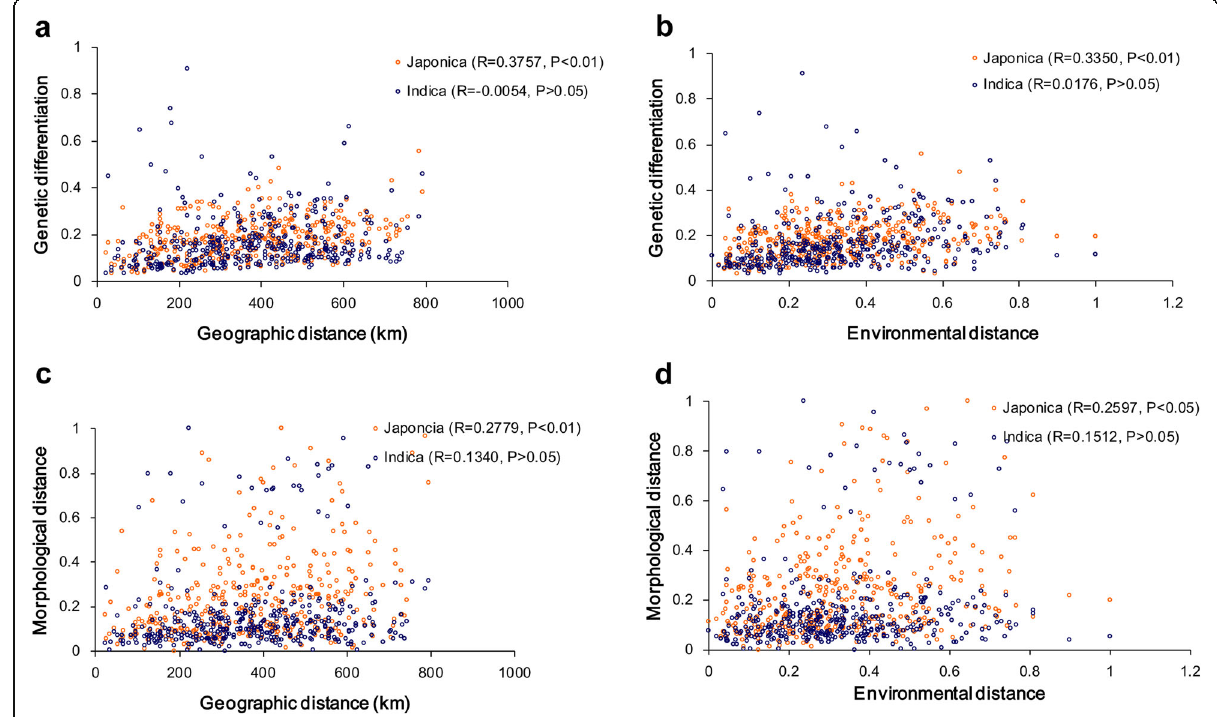
Fig. 4 Patterns of isolation by distance ( a , c ) and by environment ( b , d ) across the rice landraces from 28